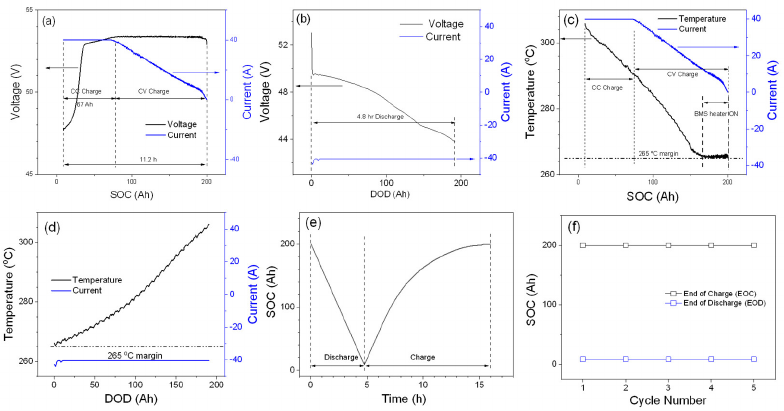
Figure 1. Module performance of full-capacity testing. ( a , b ) Voltage and current profile for the charge and dis-charge. ( c , d ) Temperature and current profiles of the charge and discharge pro-cesses. ( e ) SOC vs. time. ( f ) SOC at EOC and EOD. Charge voltage and current graphs vs. the SOC of the module are plotted in Figure